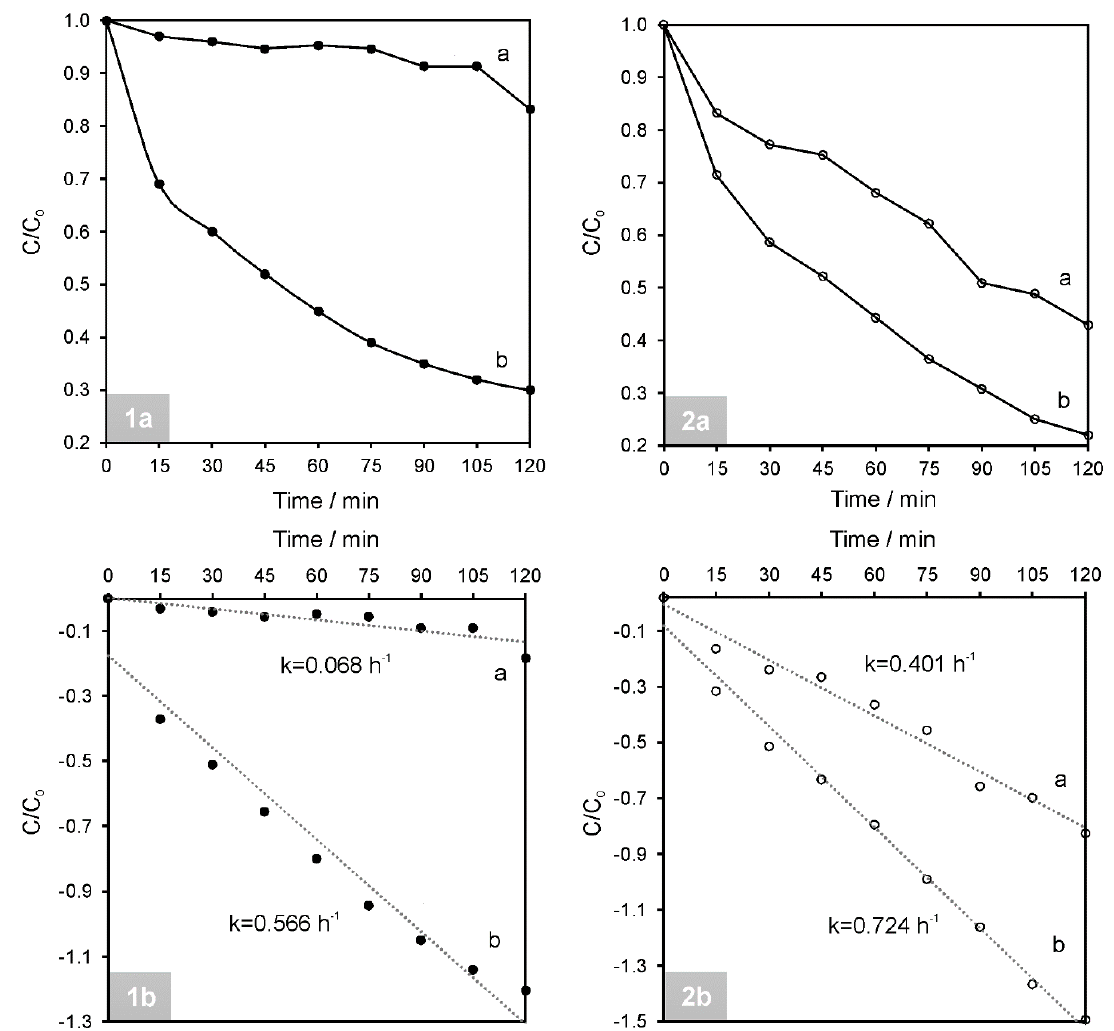
Figure 9. Residual ( 1a and 2a ) concentration ratio (C t /C 0 ) and ( 1b and 2b ) kinetic curves as a function of time under the simulated solar light irradiation of ( 1 ) RhB and ( 2 ) PH aqueous solutions in the presence of ( a ) NiAl 2 O 4 and ( b ) NiAl 2 O 4 /GQDs.